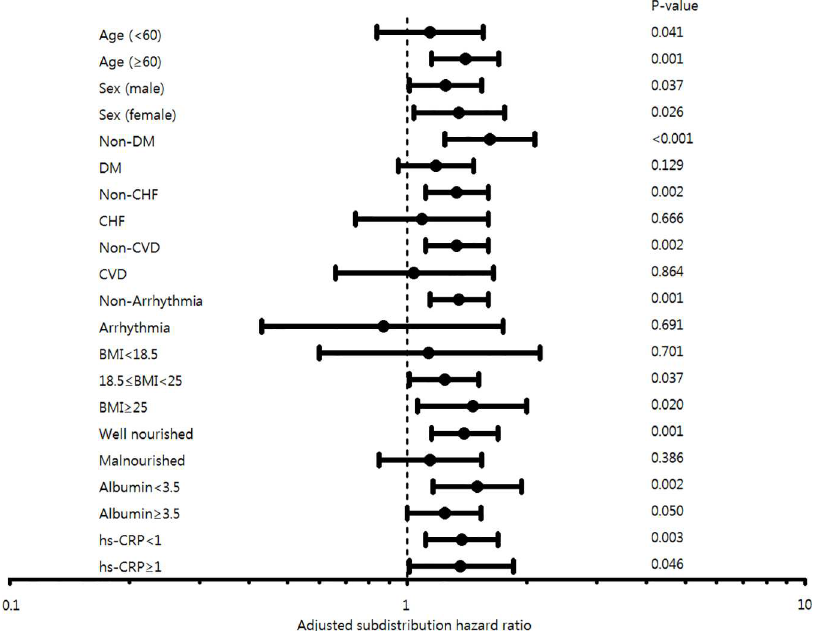
Fig 4. Forest plot representing log hazard ratios for mortality risk in the entire study cohort patients with serum potassium < 4.5 mmol/L. Results assessed accordingto known or potentialrisk factors. Abbreviations: DM, diabetes mellitus; CHF, congestive heart failure; CVD, cardiovascular disease;BMI, body mass index; hs-CRP, high sensitivity